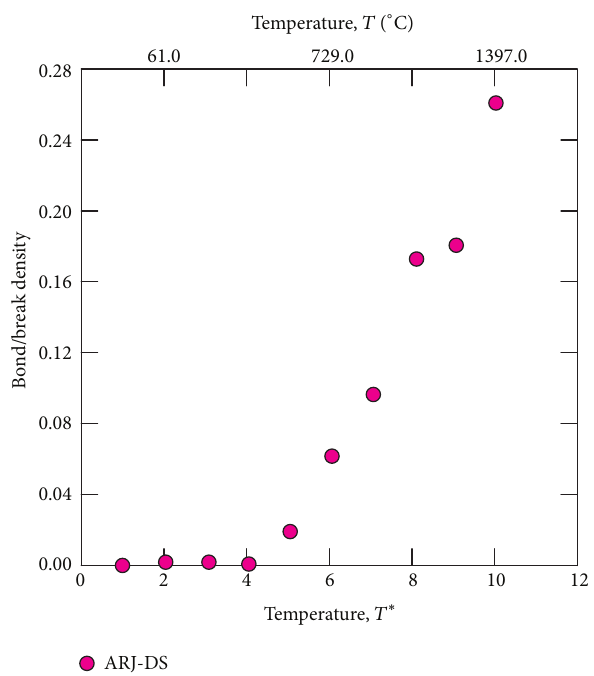
Figure 14: Effect of temperatures on the bond/break density of ARJ-DS on DLC surface.